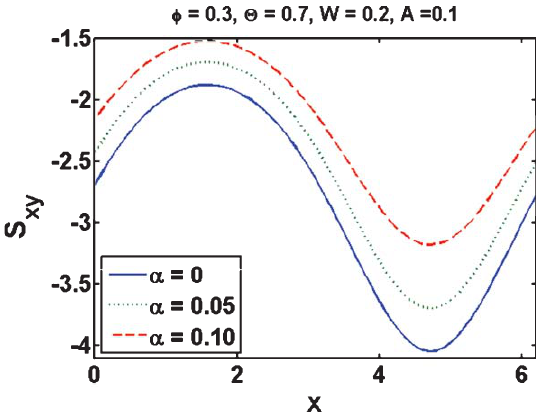
Fig. 8. Variation in shear stress ( S xy ) against y for different values of amplitude ratio ( φ